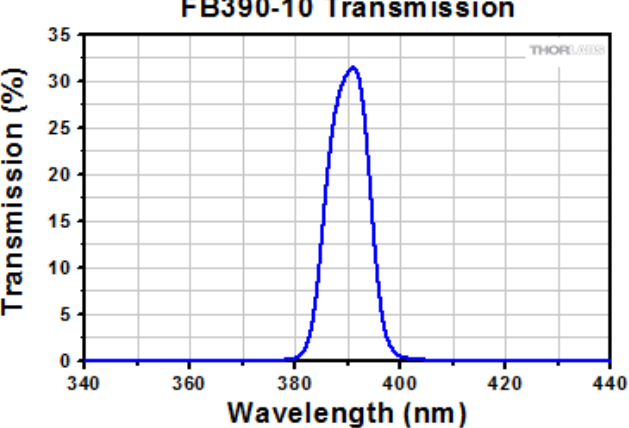
Figure 8. Transmission of